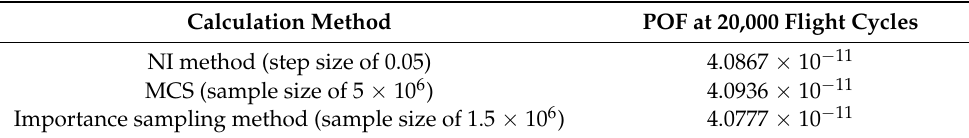
Table 3. POFs at 20,000 flight cycles for different methods.